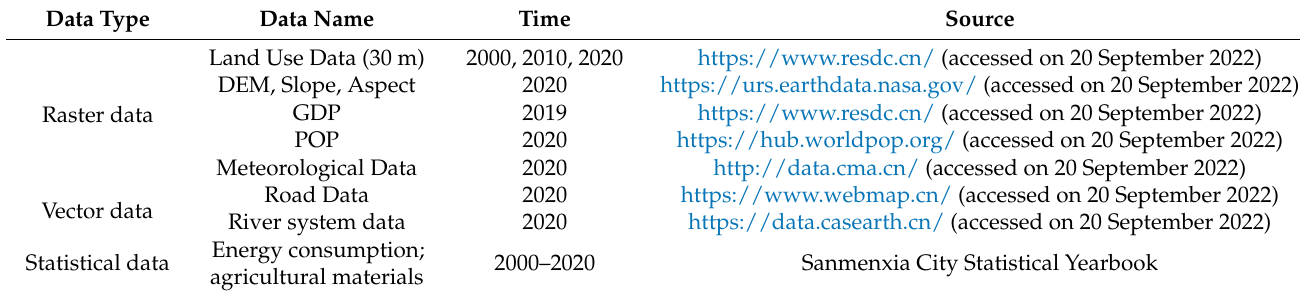
Table 1. Details of all data.